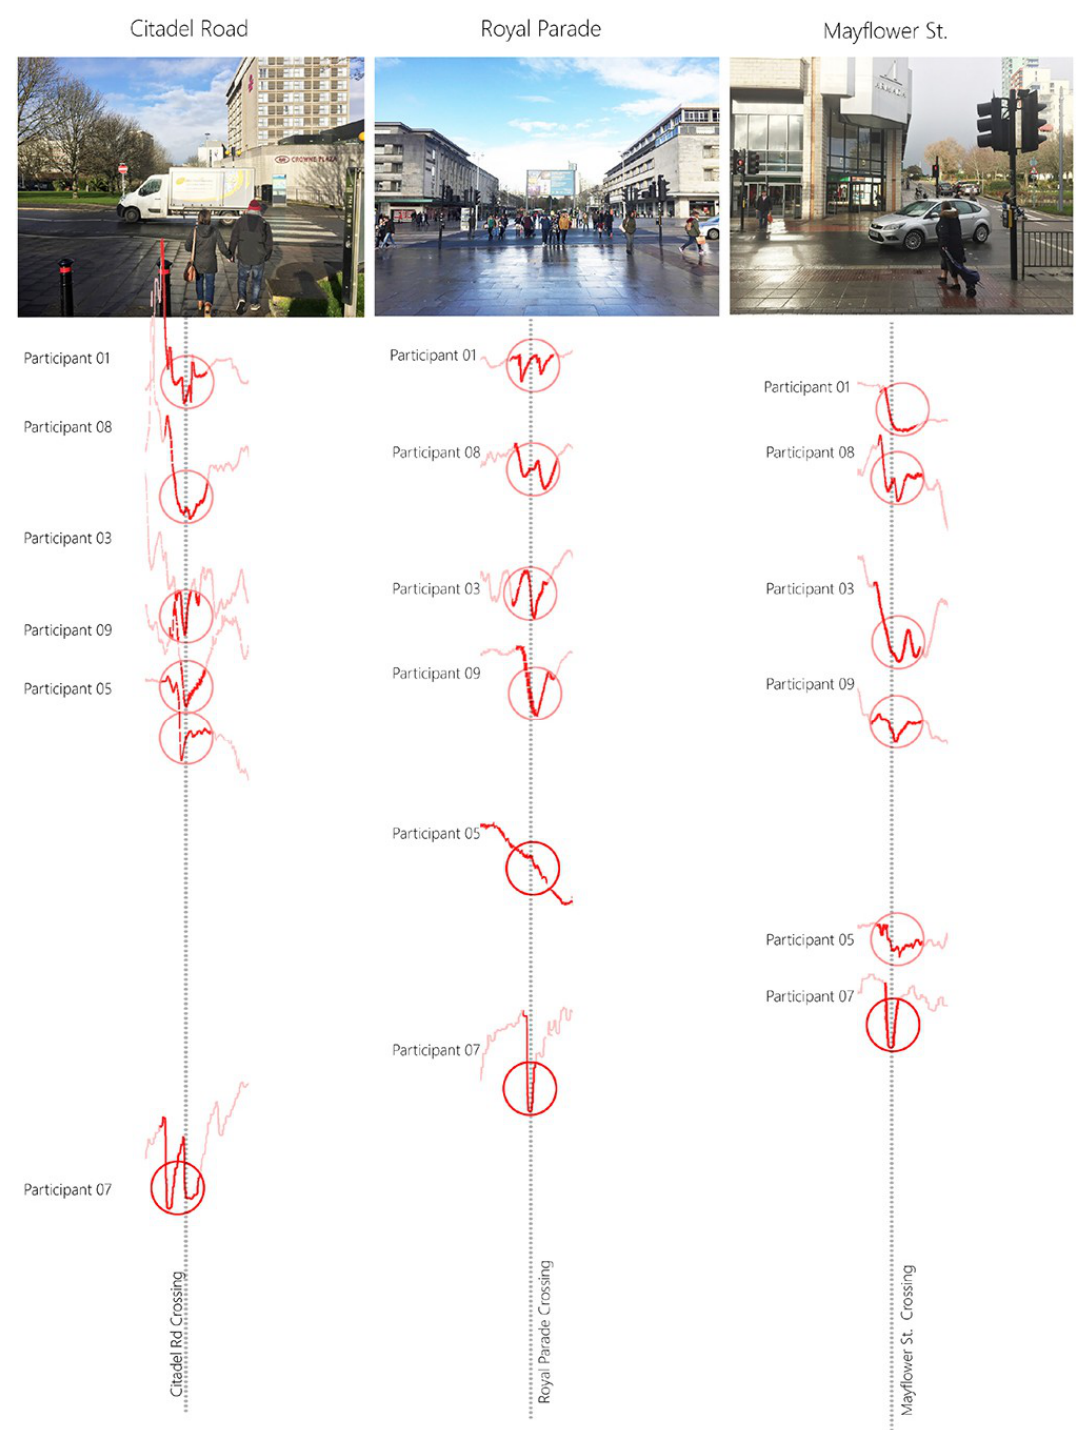
Figure 11. Crossings at Citadel Road, Royal Parade and Mayflower Street recorded the highest number of participants (all of the 6 participants) experiencing a stress ‘peaks’.